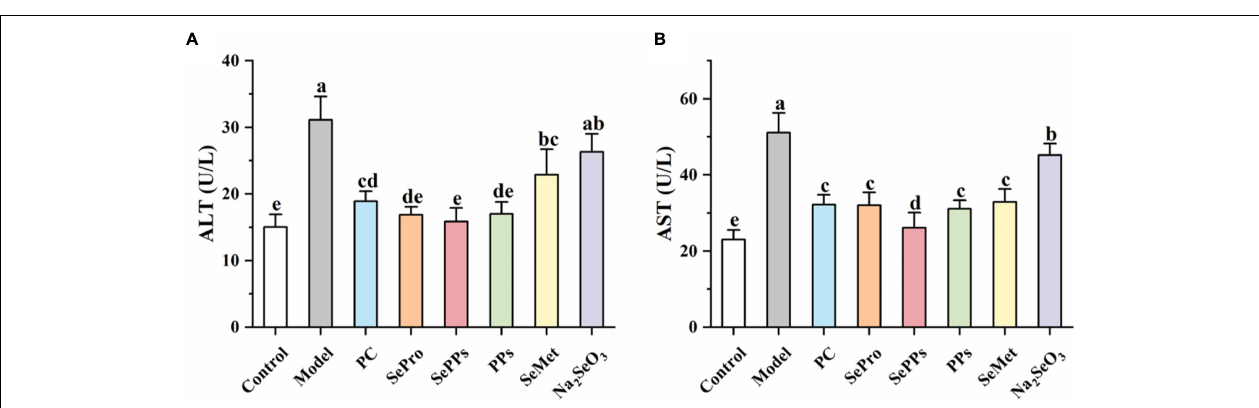
FIGURE 2 | Effects of different selenium supplements on CAT (A) , SOD (B) , MDA (C) , GSH (D) , and GSH-Px (E) in rat serum. Values are expressed as the mean ± SD, results marked with the same letters were not significantly different ( p > 0.05).